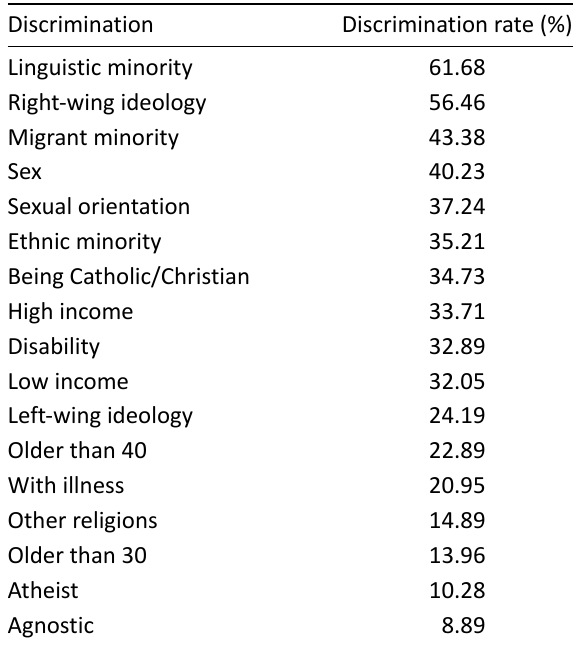
Table 4. Discrimination